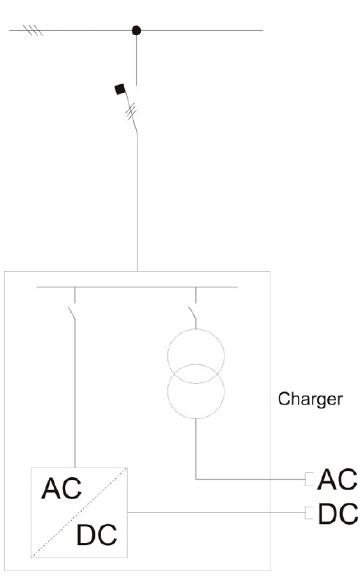
Figure 1. General one-phase connection of charging station.